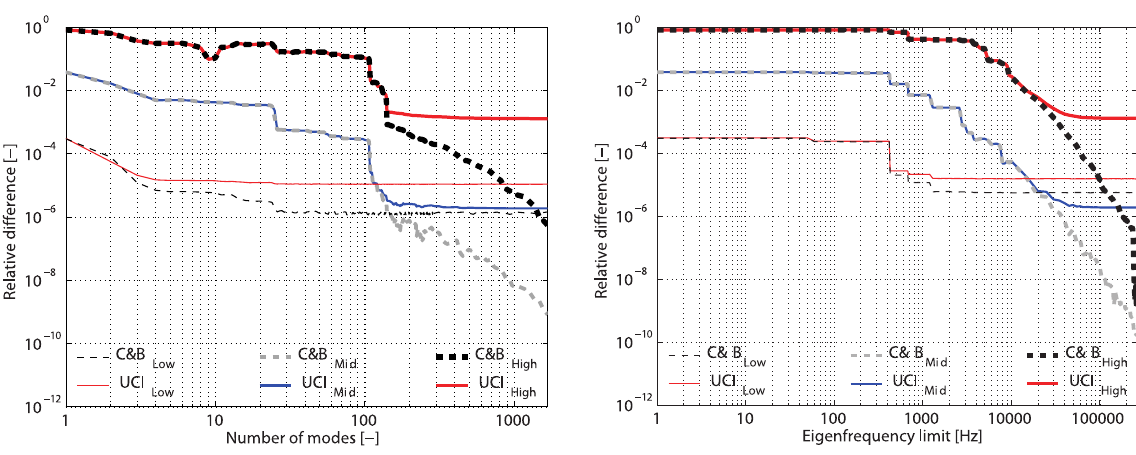
Fig. 9. The total relative difference between the modal solutions and Fig. 10. The total relative difference between the modal solutions and the direct solution for the three frequency bands, plotted as a function the direct solution for the three frequency bands, plotted as a func- of the number of included modes inner in each substructure. C&B tion of the eigenfrequency limit of included inner modes. C&B method method (dashed lines) UCI approach (solid lines). (dashed lines) UCI approach (solid lines). as low (0 − 100 Hz), mid (100 − 600 Hz) and high (600 − 1000 Hz), mainly for evaluation purposes. In Fig. 7 the solution de fi ned as above is plotted for different Young’s modulus of the “soft” connectors. When the